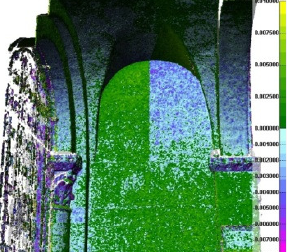
Figure 19. The error map highlights a jump in the Photon data. The discontinuity presents an inflection point in the edge that divides the wall face and vault, happening between the vertical quadrant and the horizontal one, a way change in the vectors of displacement normal for the compared clouds. This event answers to a possible translation and draft of the scanner laser equipment with regard to his initial position, happening a change of the reference point, fundamentally in the X and Z axes, for what the displacement or "nod" will have different components in both axes. The maximum of this gap on the wall face is of 0.013 m while, on the flying buttress (vertical quadrant) it is 0.008 m. This estimation takes incorporated the scale error between the scanners described in the section